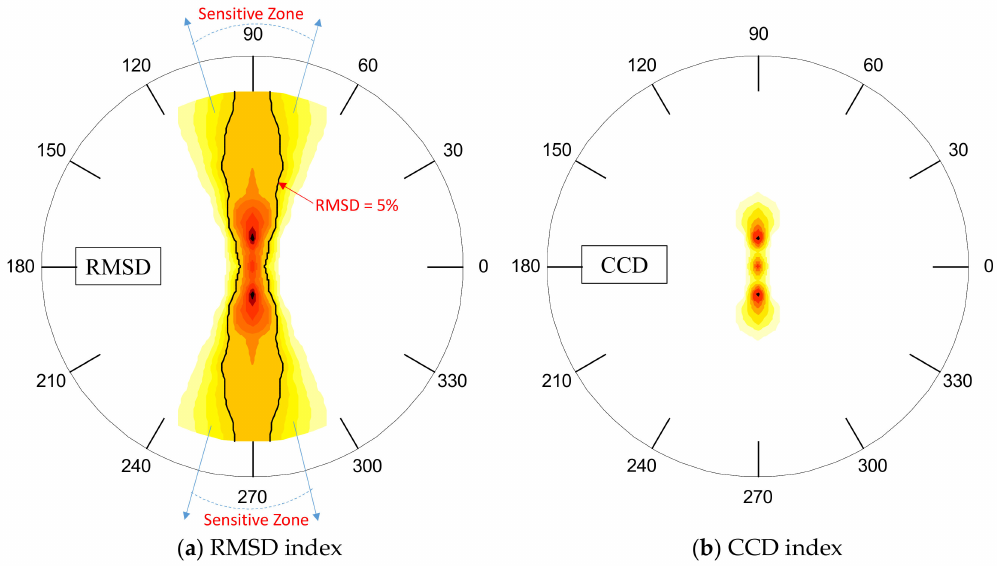
Figure 8. Detectable zone of PZT interface over circular plate domain: Peak 2 in 30–40